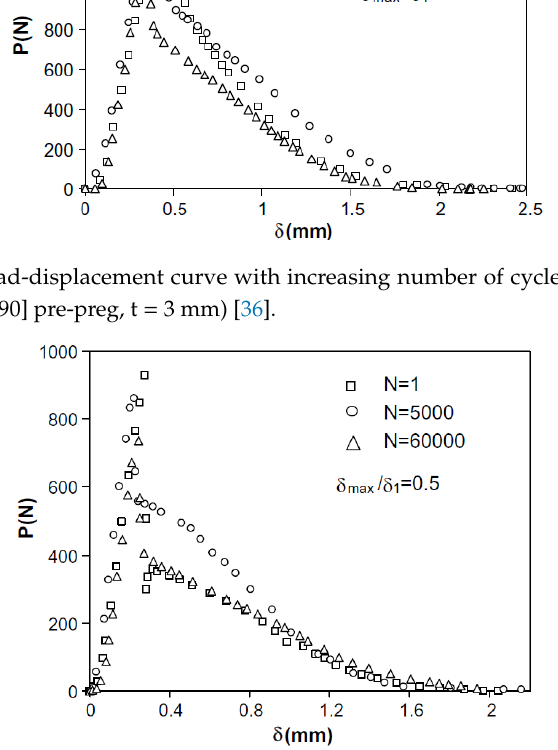
Figure 38. Pull-out load-displacement curve with increasing number of cycles (CFRP z-Pins, 7 × 7 array, d = 0.28 mm, [0 / 90] pre-preg, t = 3 mm)